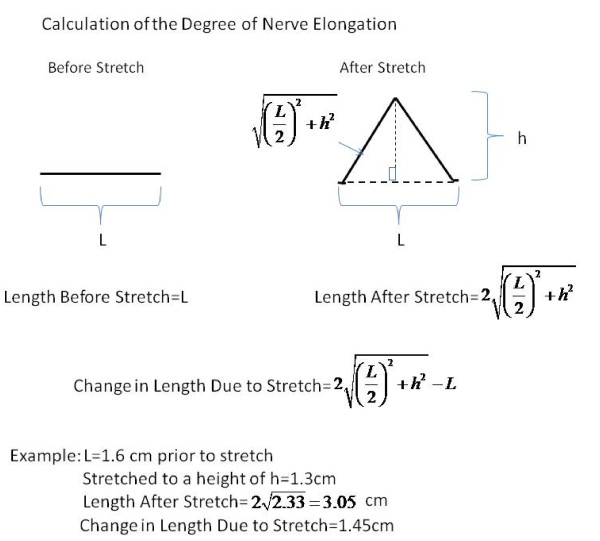
Computation of the degree of elongation of the nerve during stretch.